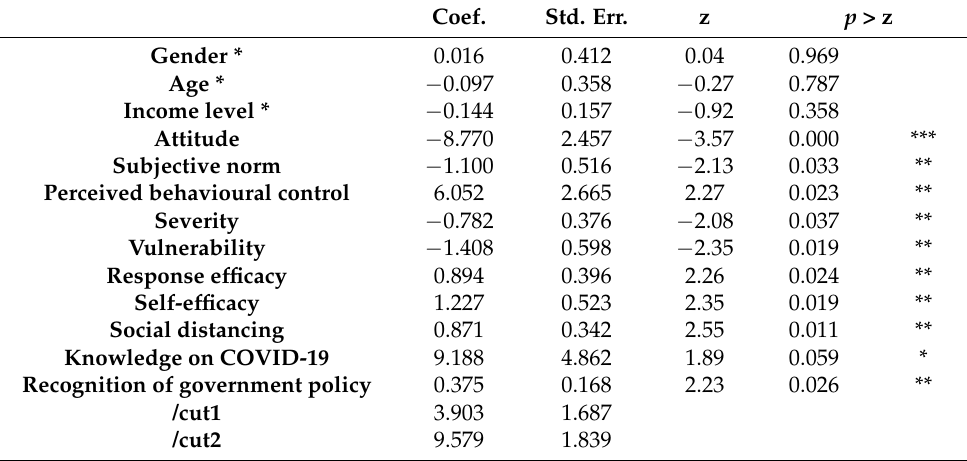
Table 6. Determinants leading to selection of online shopping channels after stabilization of COVID-19. Coef. Std. Err. z p > z Gender * 0.016 0.412 0.04 0.969 Age * − 0.097 0.358 − 0.27